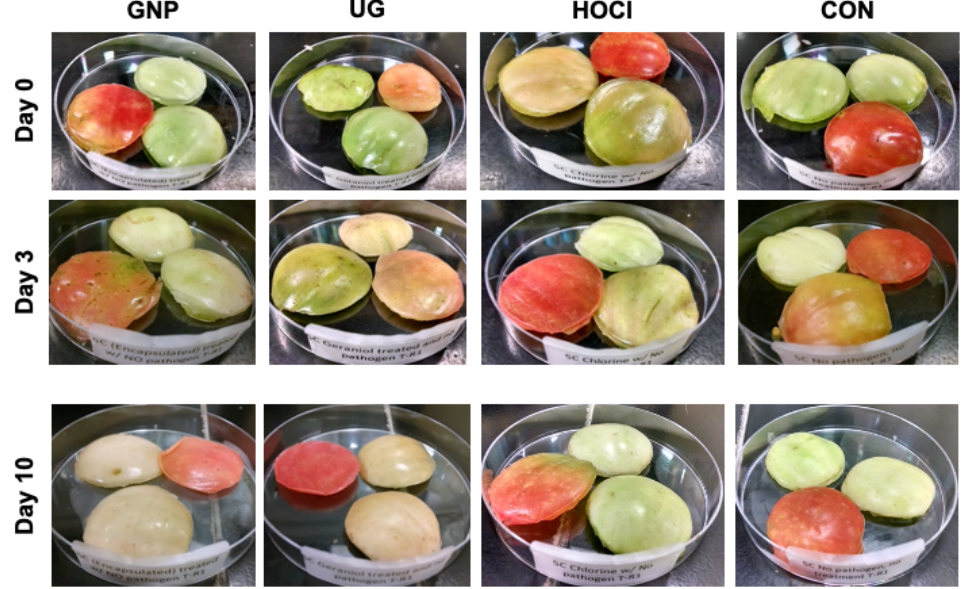
Figure 4. Changes in tomato skin appearance following sanitization treatment. GNP (0.5 wt.% ge- raniol in polymeric nanoparticles), UG (0.5 wt.% unencapsulated geraniol in sterile distilled water), HOCl (200 mg/L hypochlorous acid), CON (sterile distilled